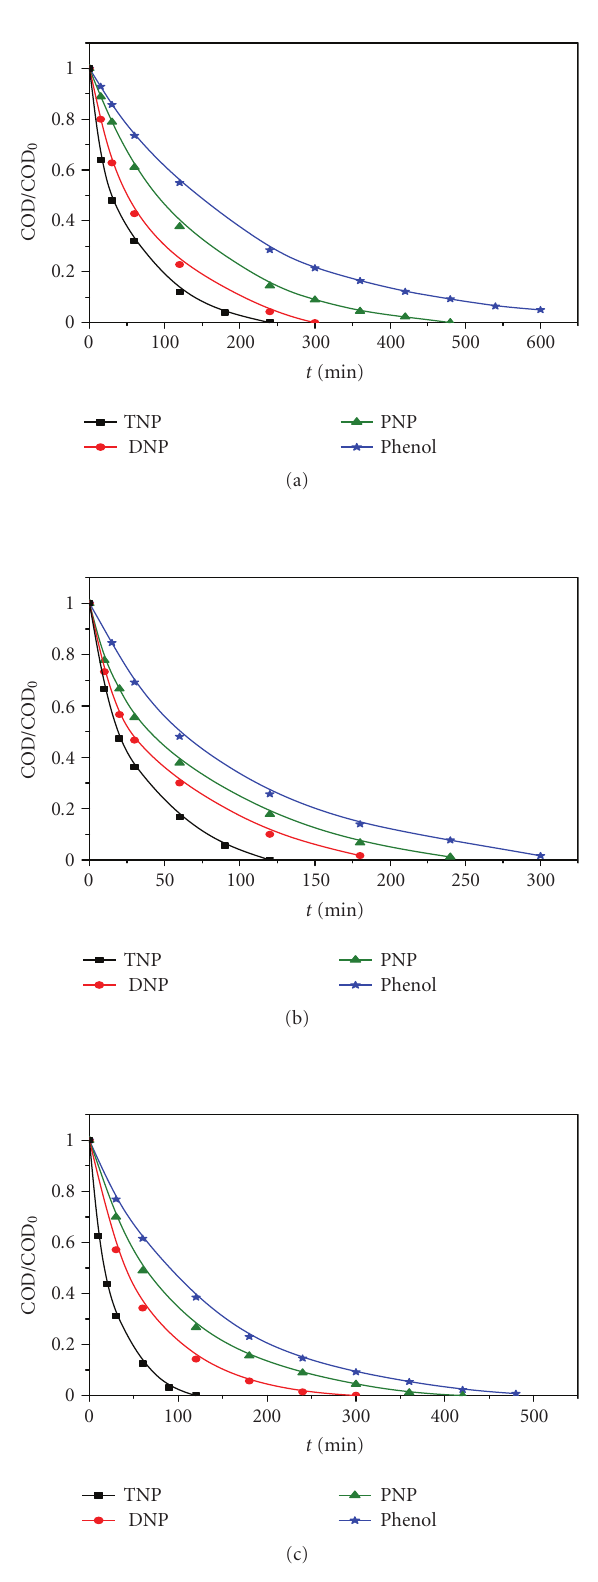
Figure 6: Kinetics of COD disappearance of nitrophenols in pres- ence of di ff erent catalysts ((a) Degussa P25, (b) Millennium PC- 500, and (c) PC-500 supported on Ahlstrom paper 1048). Experi- mental conditions: C 0 = 30mg/L, [P25] = [PC500] = 0.5 g/L, V = 1L, natural pH.